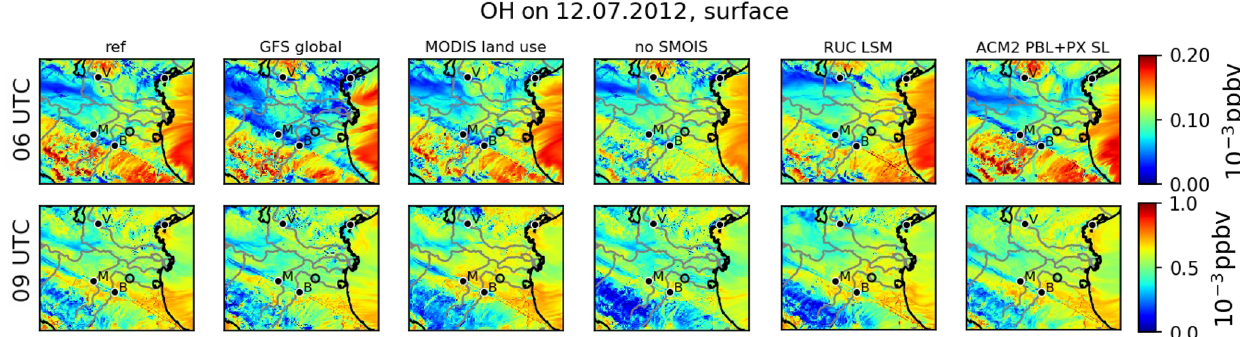
Figure 8. OH surface concentrations on 12 July 2012 at 06:00 and 09:00UTC (coded by color) for different model configurations. Plotting conventions are like in Fig.